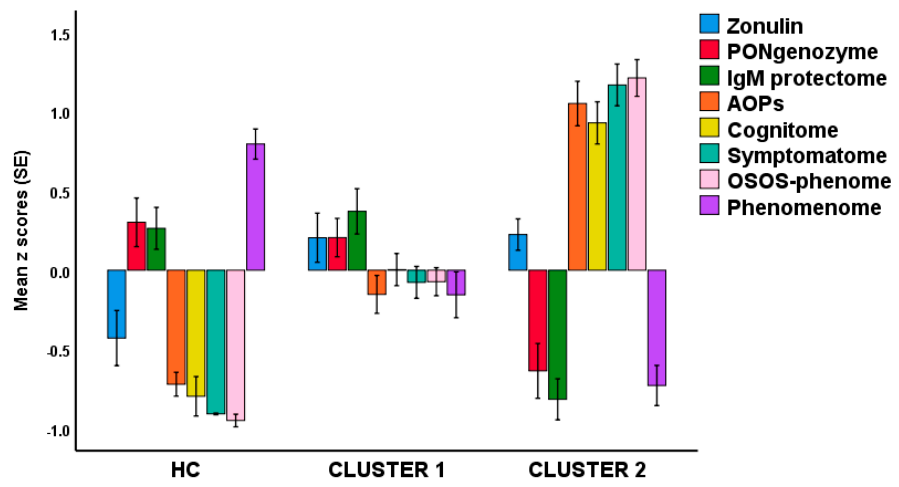
Figure 4. Latent variable scores in healthy controls (HC) and schizophrenia patients divided into two clusters. The scores reflect IgM to zonulin, a combination of CMPAase activity and the Q192R PON1 genotype (PONgenozyme), natural IgM to oxidative specific epitopes; AOPs: advanced outcome pathways; OSOS-phenome: overall severity of schizophrenia score which combines the AOP + cognitome + symptomatome feature scores. Brain Sci. 2020 , 10 , x FOR PEER REVIEW